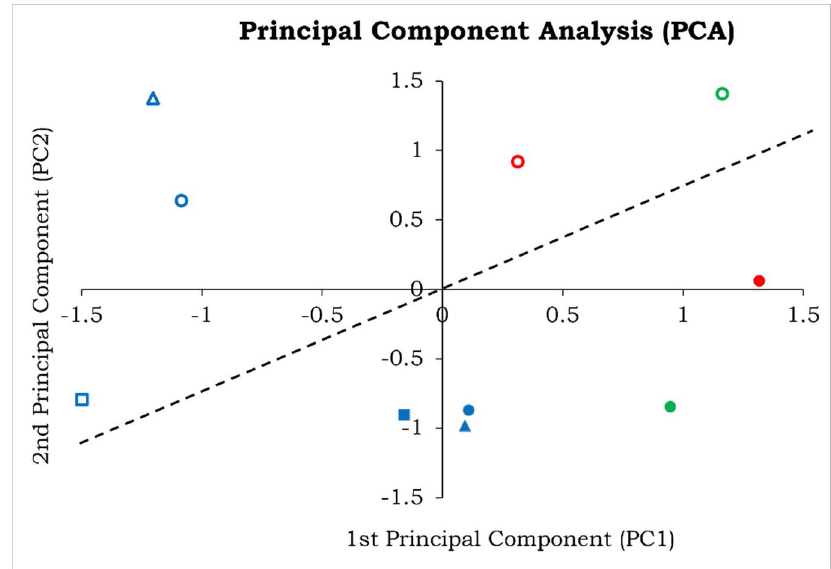
Figure 2. Principal components analysis (PCA) of R. cordifolia L antioxidant activity in PVPP untreated (–PVPP, empty symbols) and treated (+PVPP, solid plain symbols) extracts. The different samples and extractions conditions have been indicated with different shape and color symbols: methanol = circle; ethanol = triangle; aqueous = square; root = blue; leaf = red and stem = green.